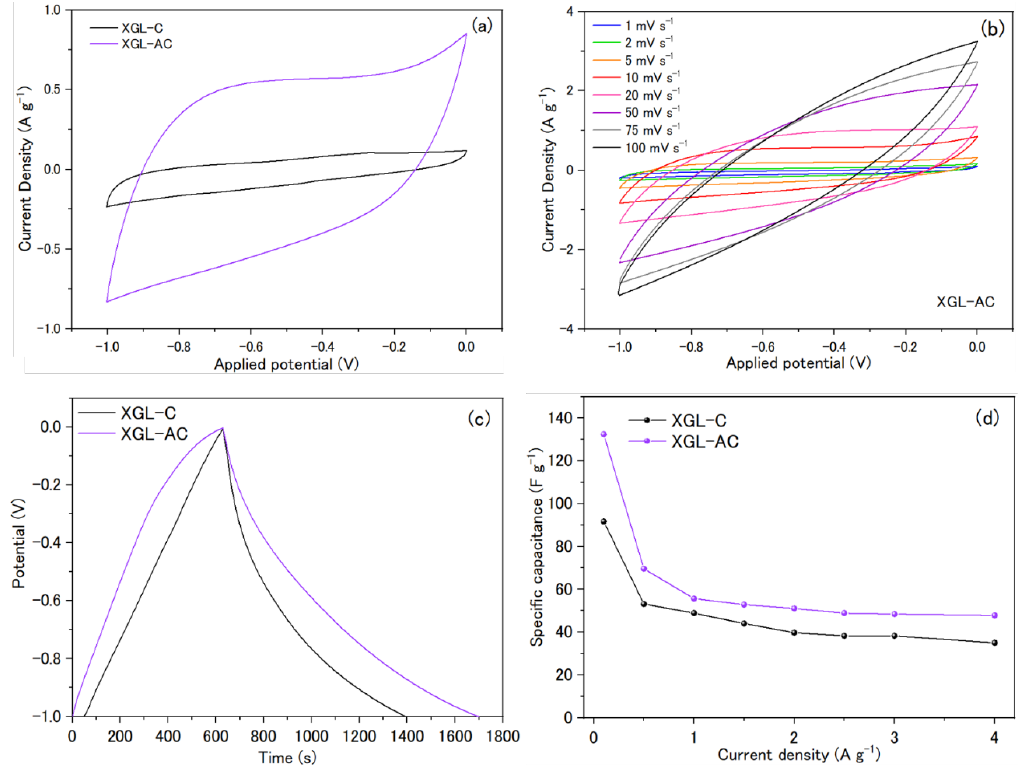
Figure 5. ( a ) CV of carbon electrodes in 6 M KOH electrolyte at 10 mV/s - ; ( b ) CV of XGL-AC at scan rates from 1 mV/s to 100 mV/s; ( c ) Charge/discharge galvanostatic curves at current density of 0.1 A/g; ( d ) Specific capacitance of carbon electrodes at different current densities in 6 M KOH.